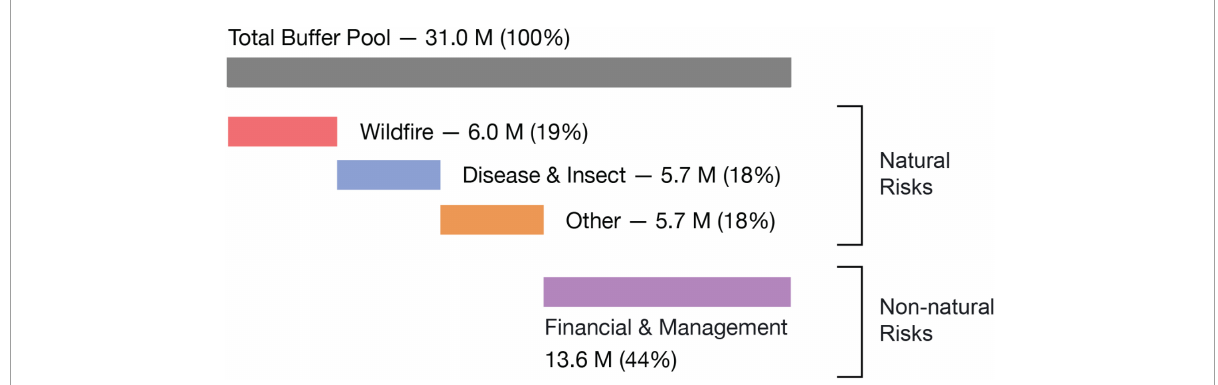
FIGURE1 California forest buffer pool composition. Projects contribute a fraction of credited carbon to a communal buffer pool intended to insure against unintentional reversals. Under the 2015 forest carbon offsets protocol, projects contribute between 8.7 and 19.2 percent of credited carbon to the buffer pool. Each risk category is assigned a reversal risk rating. Wildfire risk (red) ranges between 2 and 4 percent of credited carbon, depending on if the project has an active management plan to mitigate wildfire risks. Disease and insect risk (blue) is fixed at 3 percent. Other catastrophic risks (orange) like wind, ice, and flood events are also fixed at 3 percent. Financial and management risks (purple) vary by landowner type, such as private, public, or tribal lands, and conservation easement status. Percentage totals in the figure do not sum to 100 due to